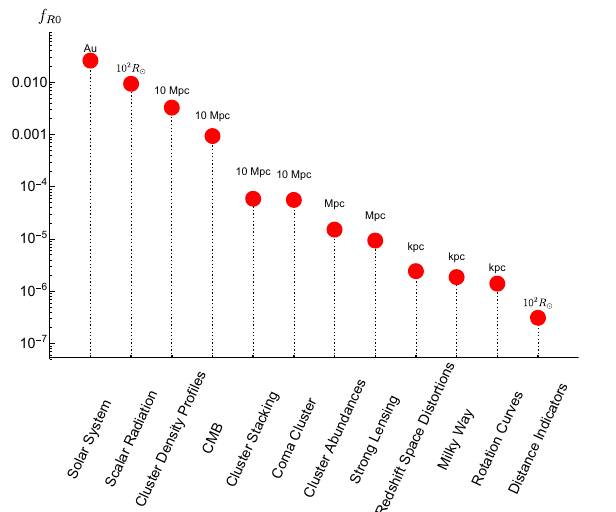
Fig. 8 Constraints on f R 0 for b = 1 Hu and Sawicki f ( R ) models (see Eq. (2.19)). The red dots indicate the upper limit for the specific test given on the x -axis and the points are labelled by the typical distance scale associated with the relevant